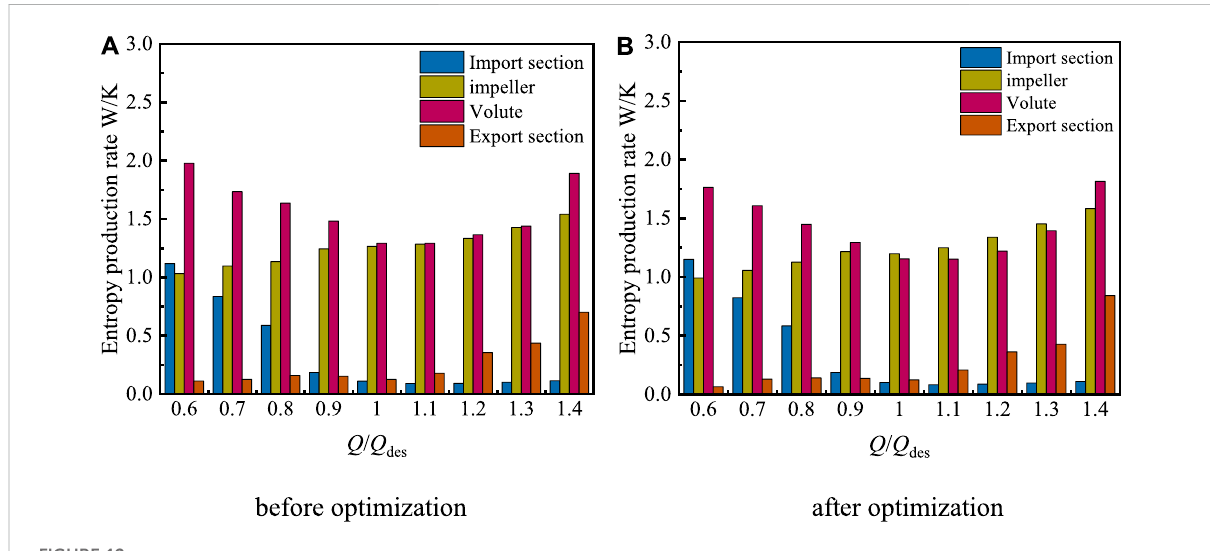
FIGURE 12 Entropy generation distribution of components under different working conditions. (A) before optimization (B) after